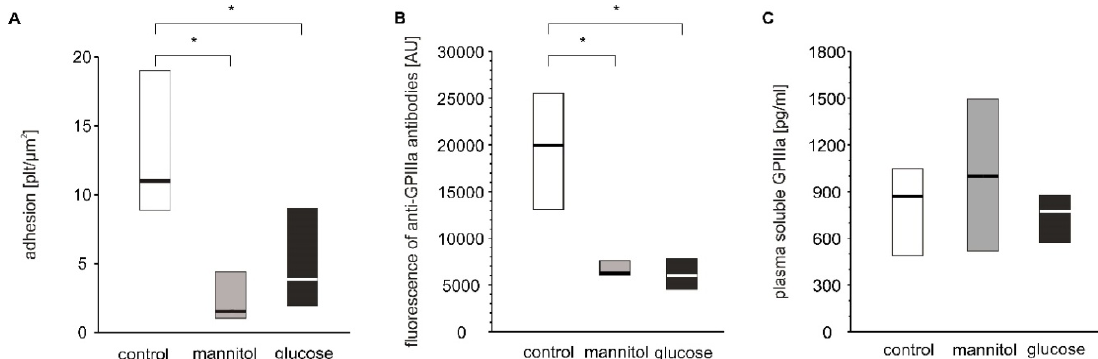
Figure 5. In vitro effects of high glucose concentrations on platelet adhesion, platelet surface membrane abundance of GPIIIa and plasma-soluble GPIIIa. Results presented as median (horizontal line) and interquartile range (box); n = 9. Mean age of 28.9 ± 10.6 years (mean ± SD). Adhesion of platelets to fibrinogen ( A ), CD61 (GPIIIa) expression on platelet surface presented as fluorescence median ( B ) and concentration of sCD61 (soluble GPIIIa) in blood plasma ( C ) were assayed after incubation of PRP from healthy donors with glucose, mannitol and Tyrode’s buffer (control) on a wheel agitator for 4 days at 37 °C. More experimental details are given in the Materials and Methods section. The asterisk denotes the particular significances estimated with ANOVA with repeated measurements, followed by post hoc Dunnet’s test: in vitro platelet adhesion: * p < 0.001, control < mannitol = glucose; CD61 expression: p < 0.001, control < mannitol = glucose.